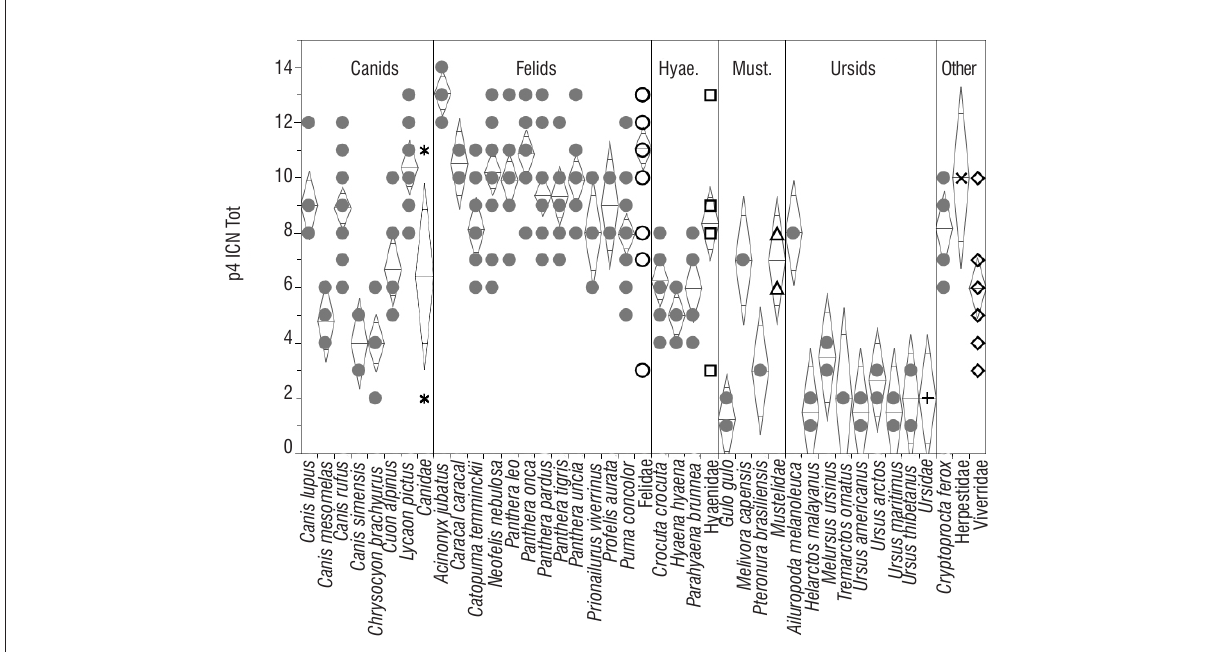
Extant taxa are represented by solid grey circles, Langebaanweg (LBW) canids are represented by asterisks, LBW felids by open circles, LBW hyaenids by open squares, LBW mustelids by open triangles, LBW ursids ( Agriotherium ) by ‘+’ signs, the single analysed LBW herpestid by an ‘x’ sign, and LBW viverrids by open diamonds. Each dotted diamond represents the mean and 95% confidence interval vertical span; the horizontal lines are the mean and ‘overlap marks’ that indicate statistical separation. Figure 10: Intercuspid notch (ICN) scores of the fourth (p4) lower premolar by